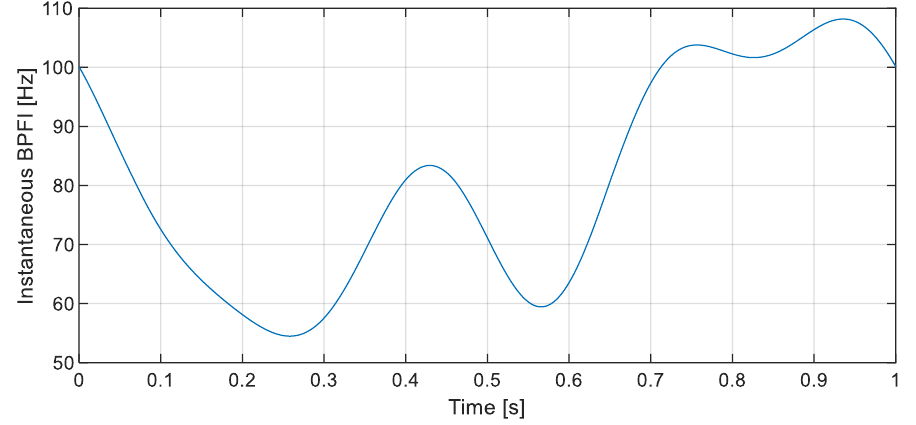
Figure 10. Instantaneous frequency of REB pulses.